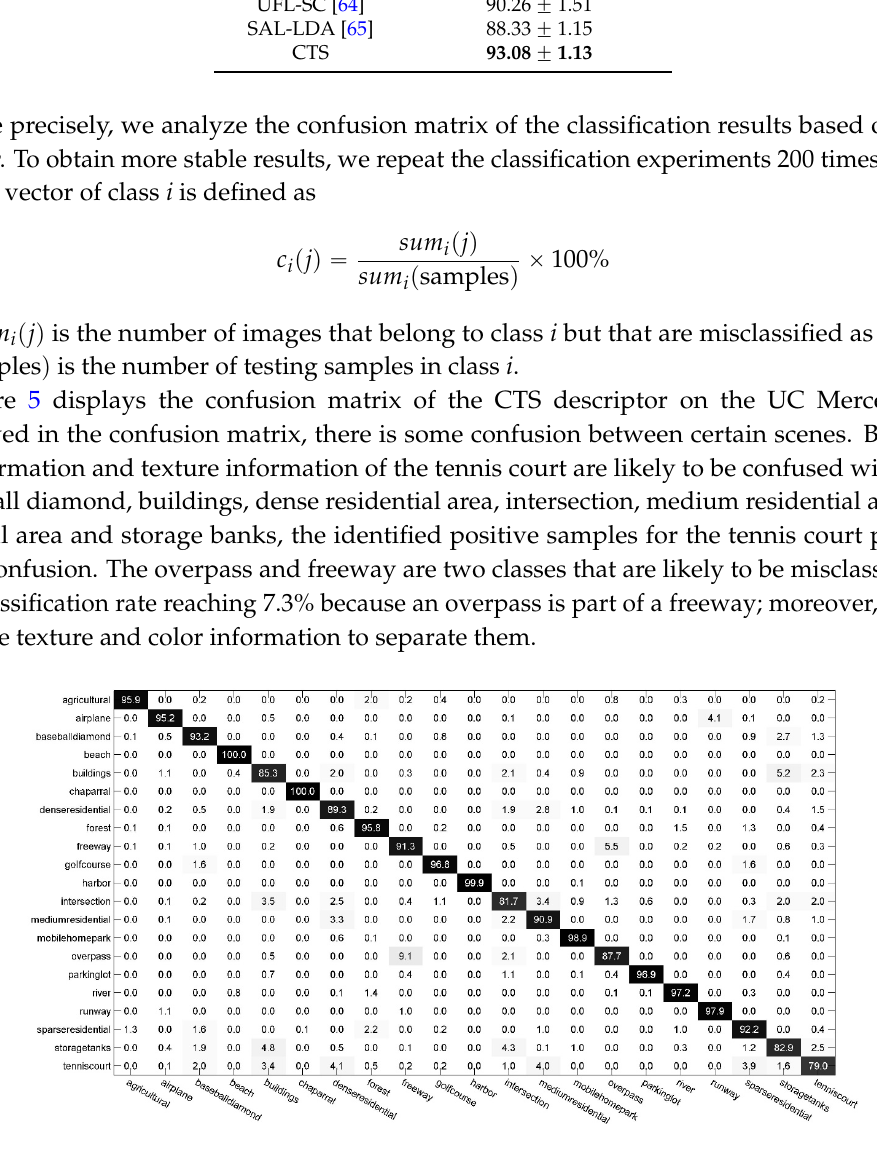
Figure 5. Confusion matrix for the descriptors based on the CTS descriptor on the UC Merced dataset.